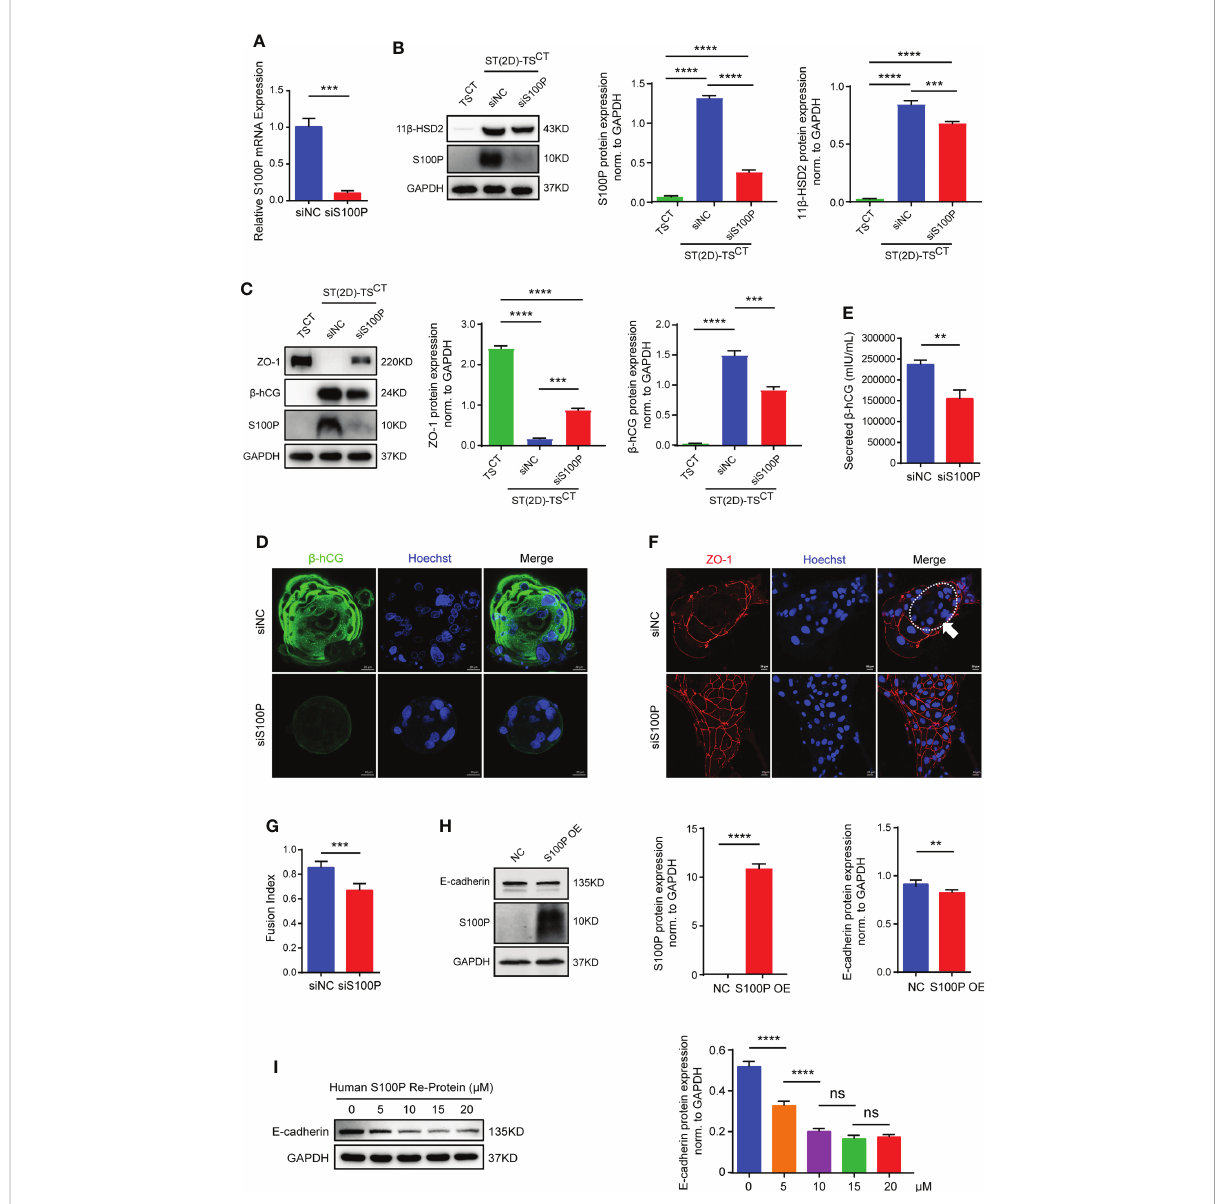
FIGURE 4 S100P is involved in regulating trophoblast syncytialization. (A) Quanti fi cation of S100P mRNA expression. The mean values ± SEMs (normalized to GAPDH ) of ST(2D)-TS CT cells (D6) are shown. *** p =0.0002. (B) Representative Western blotting of S100P and 11 b -HSD2 in siS100P-transfected ST (2D)-TS CT cells (D6). Semiquantitative analysis of S100P and 11 b -HSD2 protein expression normalized to GAPDH (n=3). *** p =0.0003; **** p <0.0001. (C) Representative Western blotting of ZO-1, b -hCG, and S100P in siS100P-transfected ST(2D)-TS CT cells (D6). Semi-quanti fi cation of ZO-1 and b - hCG protein expression normalized to GAPDH (n=3). *** p =0.0001, p =0.0003; **** p <0.0001. (D) Representative immuno fl uorescence images stained for the syncytialization marker b -hCG are shown. Hoechst staining was performed to visualize nuclei (n=3, ST(3D)-TS CT cells). Scale bars, 20 m m. (E) ELISA measurement of the b -hCG level secreted into the supernatants of the cultures of ST(2D)-TS CT cells (D6) transfected with siS100P. The mean values ± SEMs are shown. ** p =0.0038. (F) Representative immuno fl uorescence images of ST(2D)-TS CT cells (D6) transfected with siS100P with ZO-1 (red) and Hoechst staining (blue). The white arrow indicates the fusion area. Representative images of three independent experiments are shown. Scale bar, 20 m m. (G) Fusion index of ST(2D)-TS CT cells (D6) transfected with siS100P. The index was assessed in ten images, and the mean values ± SEMs are shown. *** p =0.0002. (H) Representative Western blotting of S100P and E-cadherin expression in TS CT cells infected with lentiviral vectors overexpressing S100P . Semiquantitative analysis of S100P and E-cadherin protein expression normalized to GAPDH (n=3). ** p =0.0084; **** p <0.0001. (I) Representative Western blotting of E-cadherin expression in TS CT cells treated with recombinant human S100P protein (5 m M, 10 m M, 15 m M, and 20 m M) (n=3). Semiquantitative analysis of E-cadherin protein expression normalized to GAPDH (n=3). **** p <0.0001; ns: p =0.1208, p